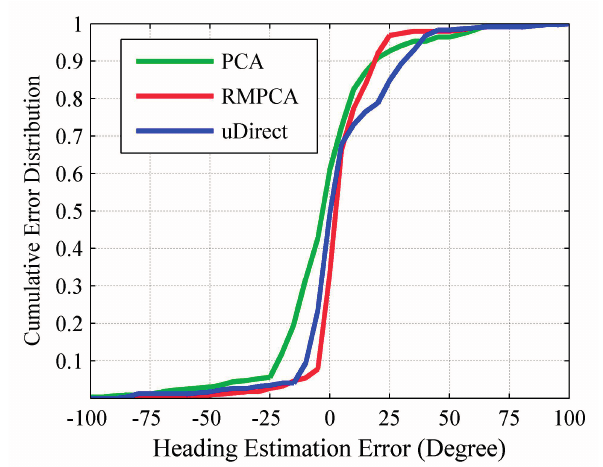
Figure 7. Heading estimation error